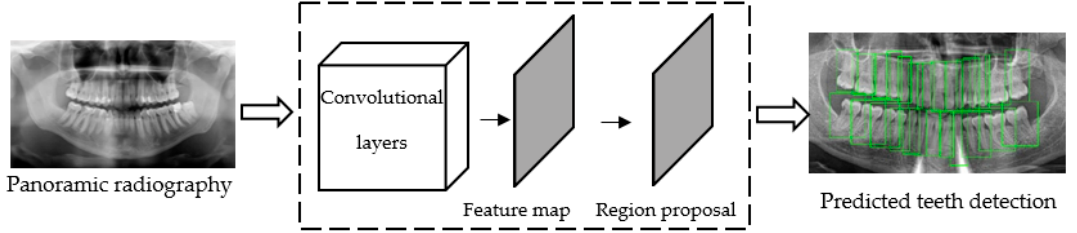
Figure 2. System architecture for teeth